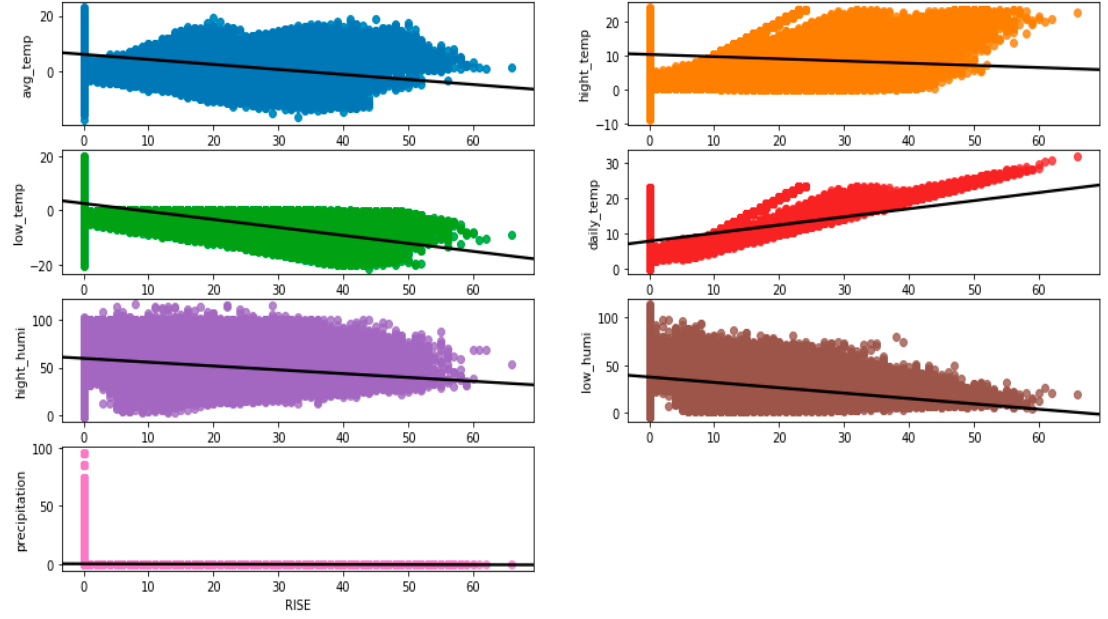
Figure 14. Correlations between variable and amount of sap.